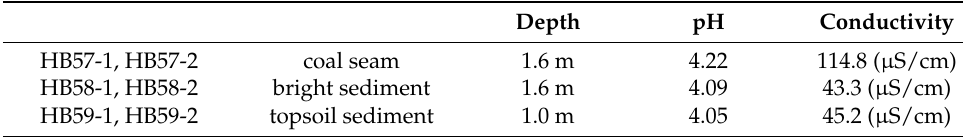
Table 1. pH and electrical conductivity of the sampling